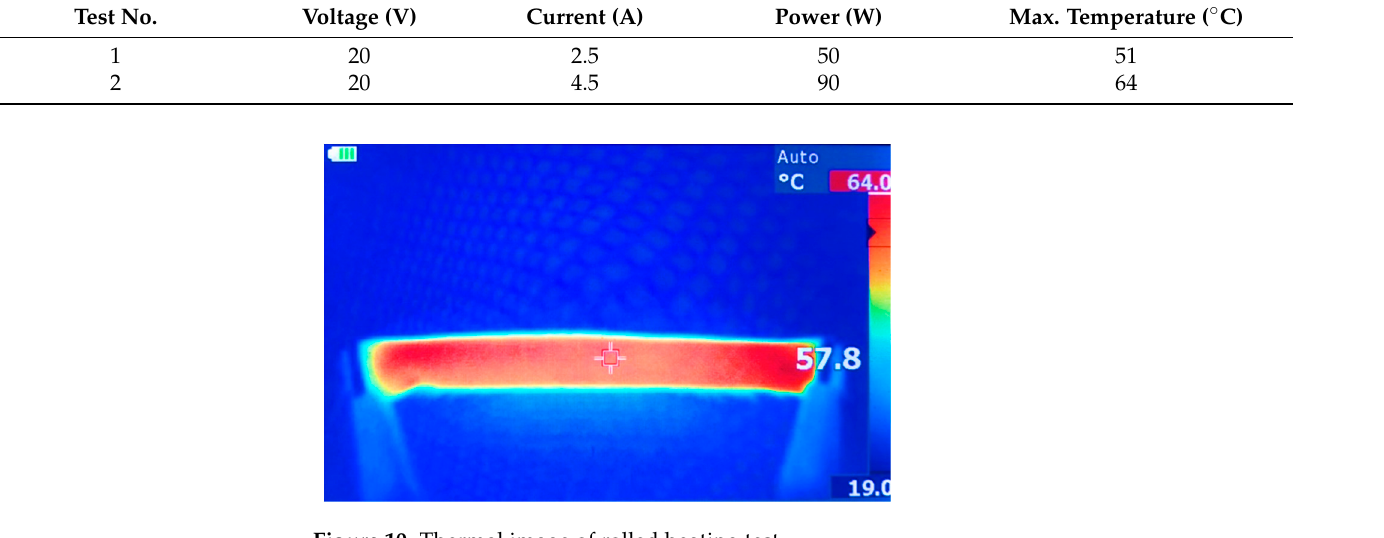
Figure 10. Thermal image of rolled heating test.